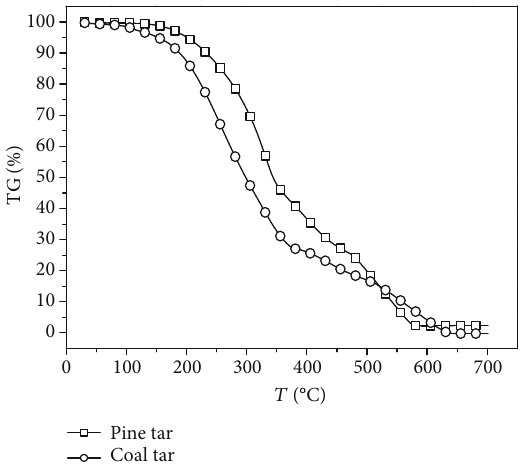
Figure 1: Thermogravimetric curve of test